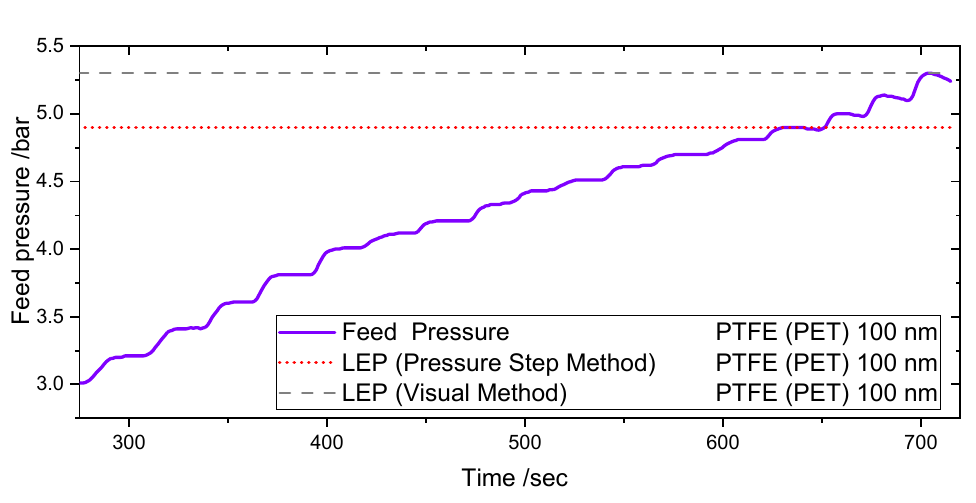
Figure 7. Pressure course during LEP detection using Pressure Step Detection in the PMMA test cell. The pressure decrease during the steps shows the achievement of the Liquid entry Pressure.